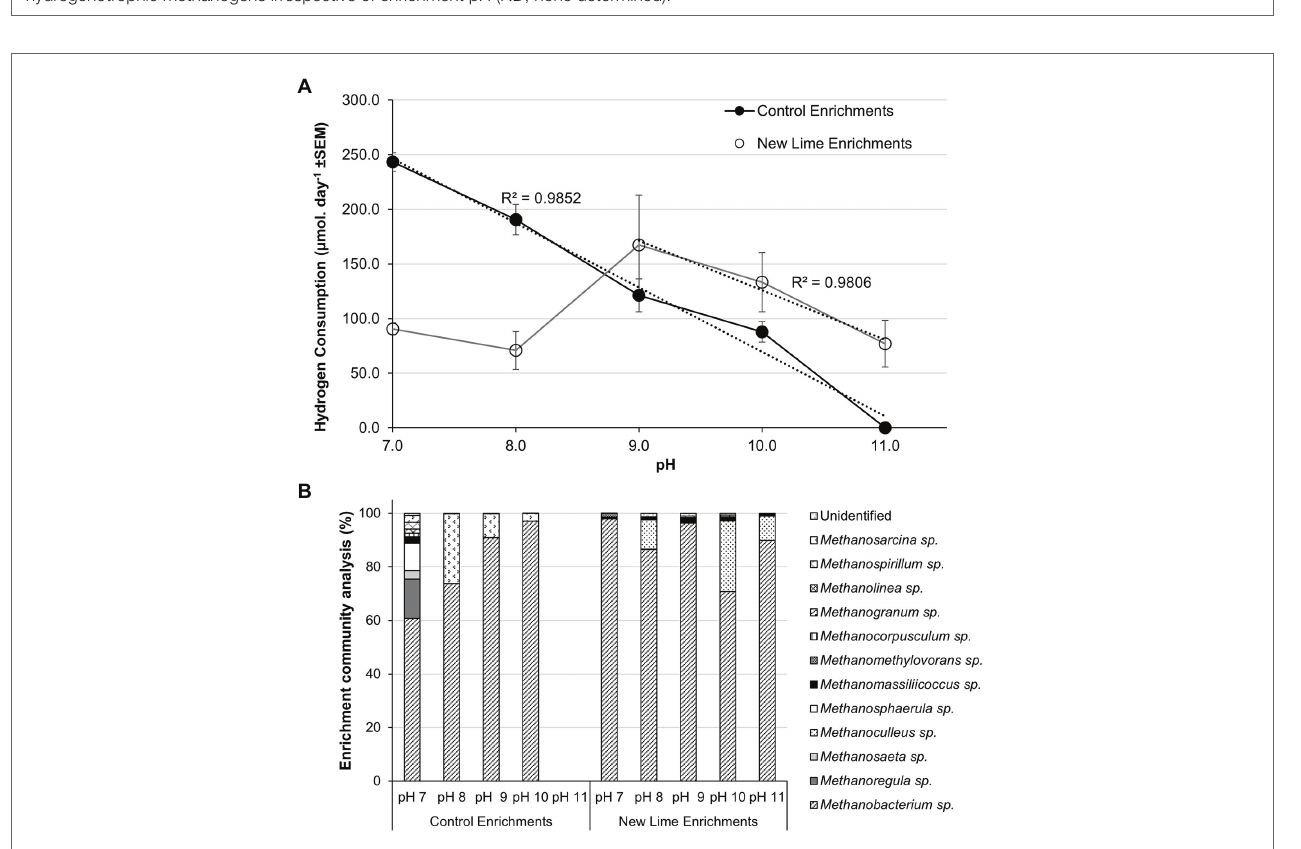
FIGURE 3 | Hydrogen consumption rates (A) and methanogen populations (B) in H 2 /CO 2 enriched microcosms from Control ( n = 2) and New Lime ( n = 6) soils. An increasing pH negatively impacted upon hydrogen consumption in Control soil enrichments ( n = 2 at all pH values), while New Lime sediments ( n = 4 pH 7.0, n = 4 pH 8.0, n = 6 pH 9.0, n = 6 pH 10.0, n = 4 pH 11.0) demonstrated an optimum pH of 9.0. Across all enrichments, Methanobacterium sp. were the dominant genus. ND, none detected (“ n ” denotes the number of replicates